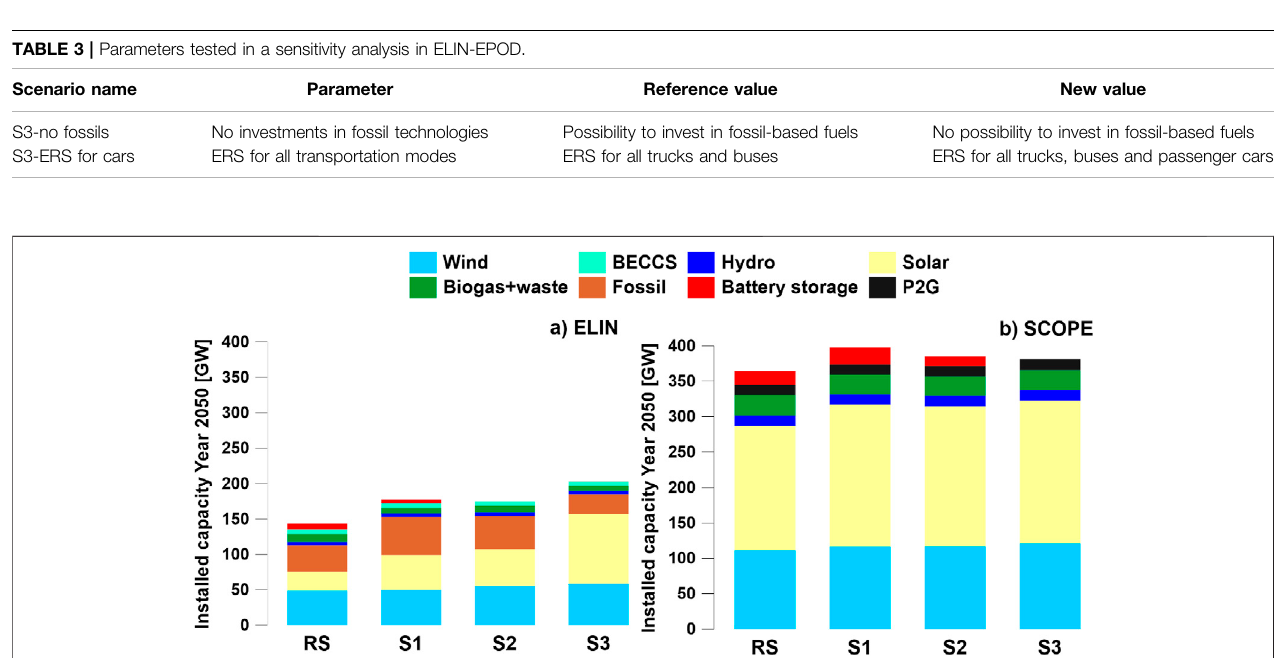
Frontiers in Energy Research |